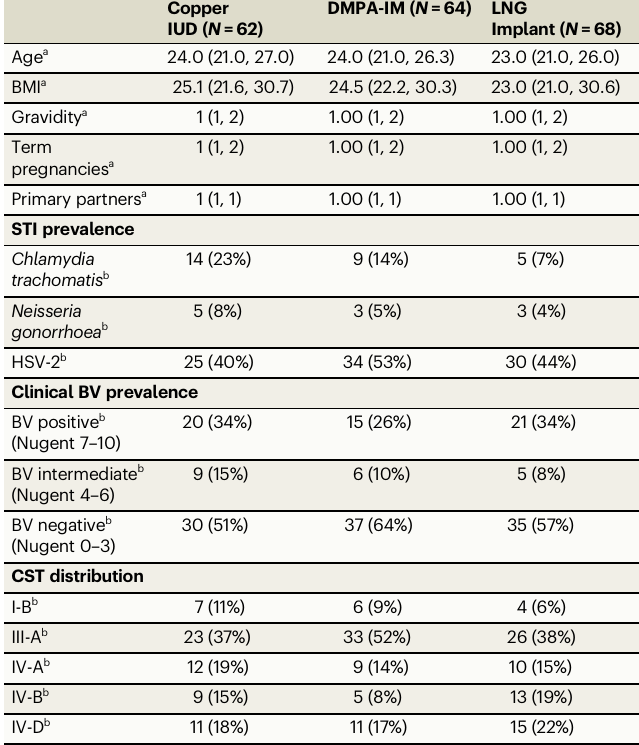
Table 1 | Baseline cohort